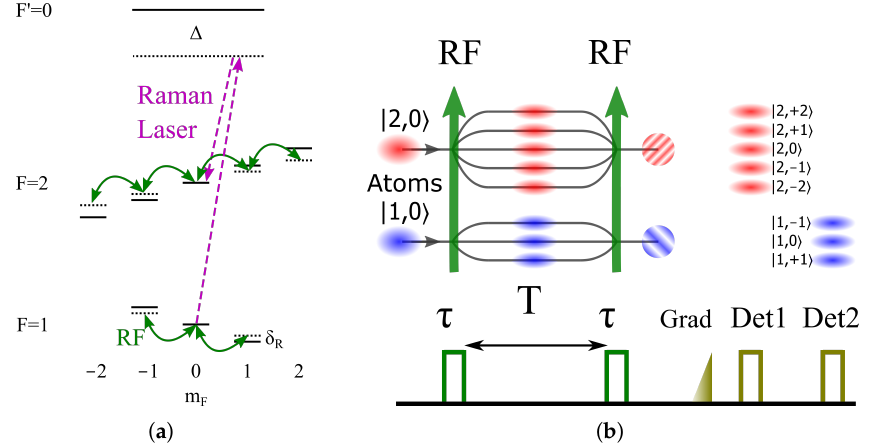
Figure 1. The level scheme ( a ) and the time sequence ( b ) of a dual multi-wave atom magnetometer. ( a ) RF radiation couples different spin states. Raman transition couples ∆ F = + 1, ∆ m F = 0 states. For clarity, only m F = 0 state is sketched. ( b ) Two RF pulses of duration τ to couple spin levels and free evolution time T form Ramsey interference in the presence of a magnetic field B . After a pulse of the magnetic field gradient, the fringes of F = 2 are read at detection step 1, and those of F = 1 are then read at detection step 2.